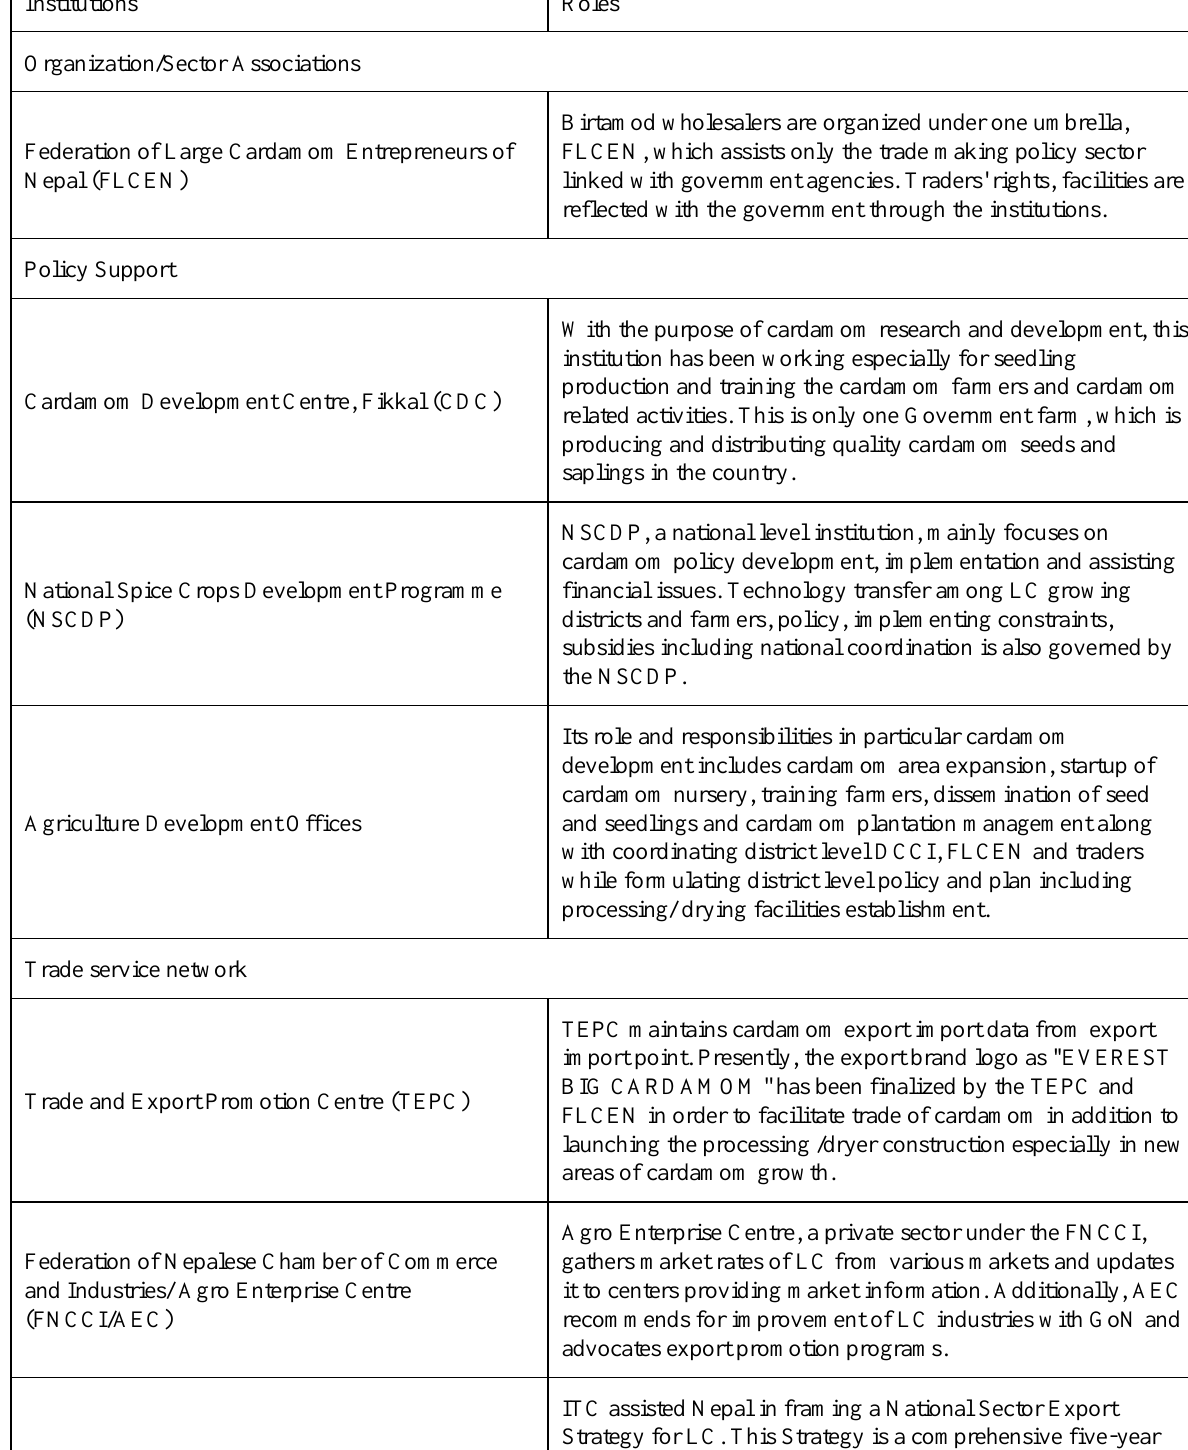
Table 12. Organizations, Enablers and Facilitators